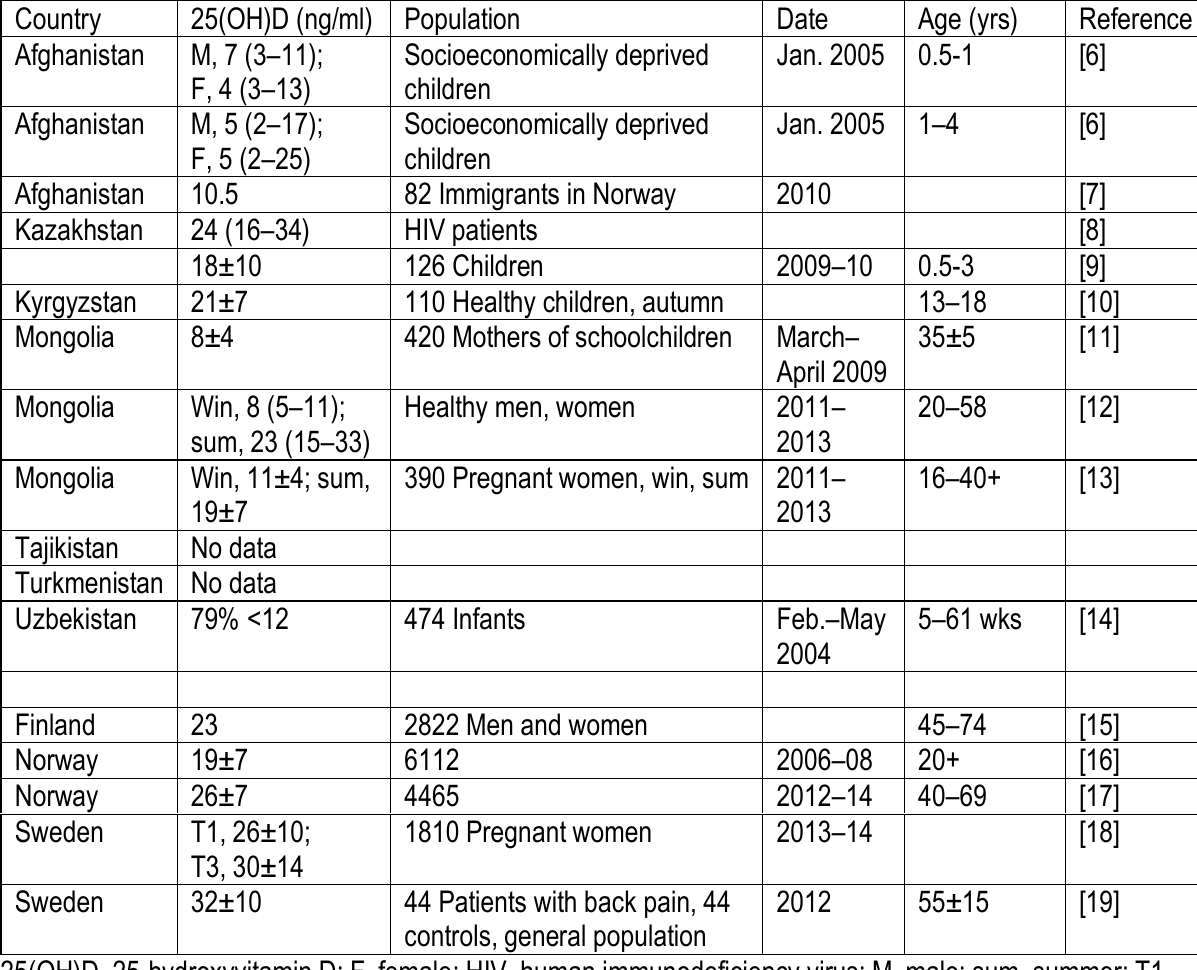
Table 3. Representative serum 25(OH)D concentrations for various countries Country Afghanistan